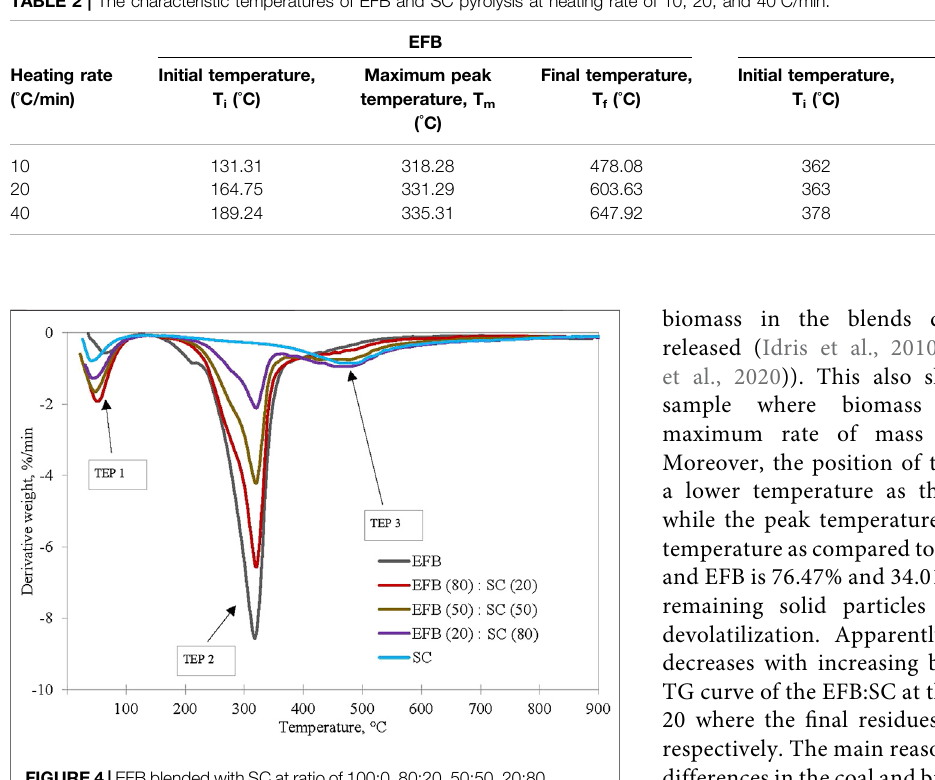
FIGURE 4| EFB blended withSC at ratioof 100:0, 80:20, 50:50, 20:80, and 0:100 under pyrolysis condition at heating rate of 10 °